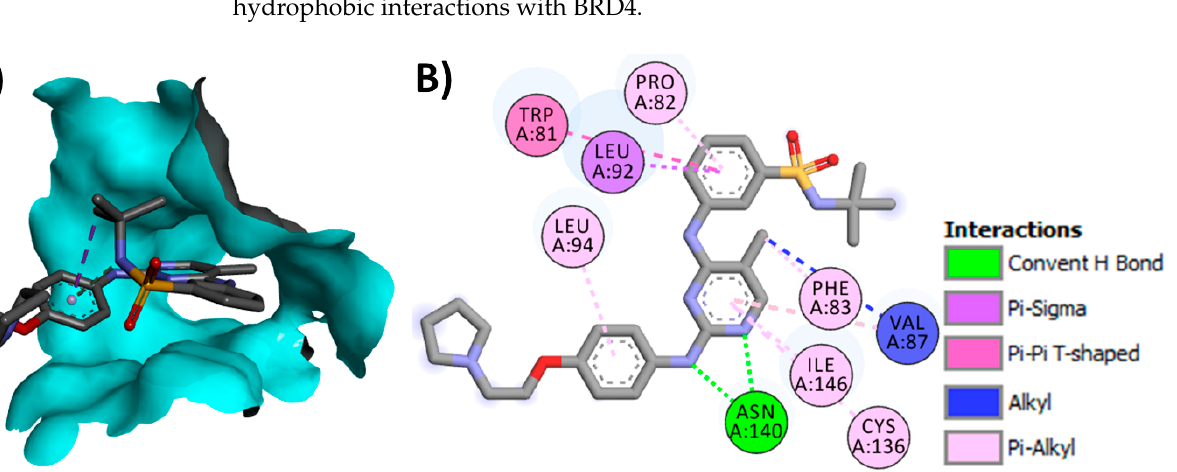
Figure 28. Binding modes of fedratinib (shown as sticks) into human bromodomain BRD4 (pdb: 4OGJ): ( A ) 3D binding mode, receptor shown as a hydrogen bond surface; ( B ) 2D binding mode showing different types of interactions with BRD4; the figure was generated using Discovery Studio Visualizer (V16.1.0.15350).